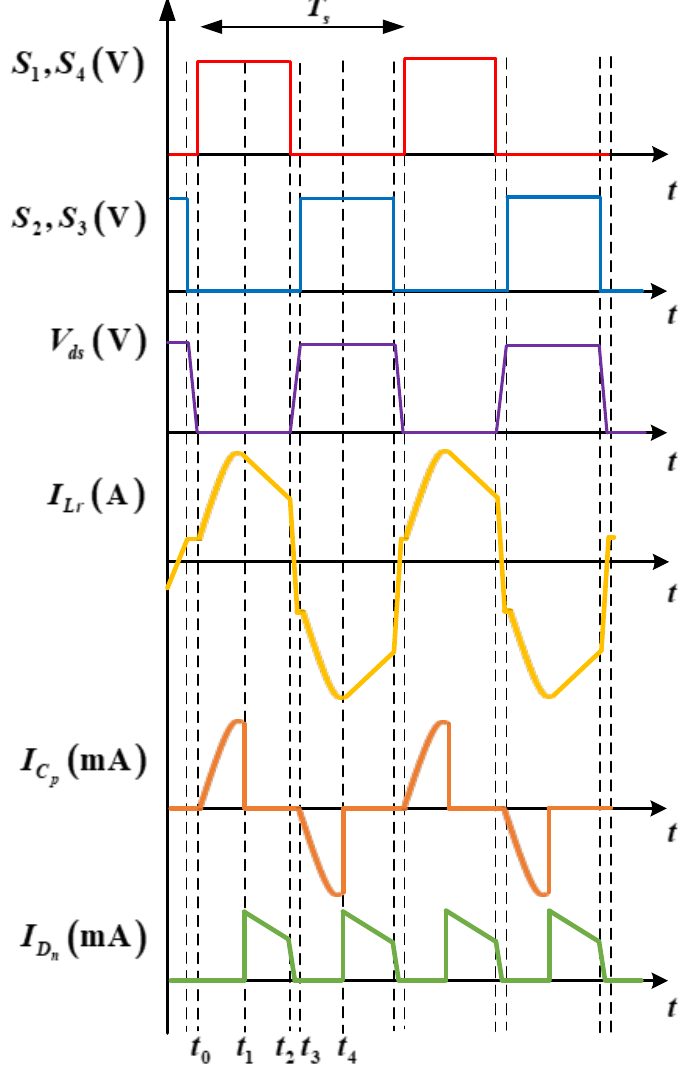
Figure 3. Key waveforms of the proposed parallel resonant converter.